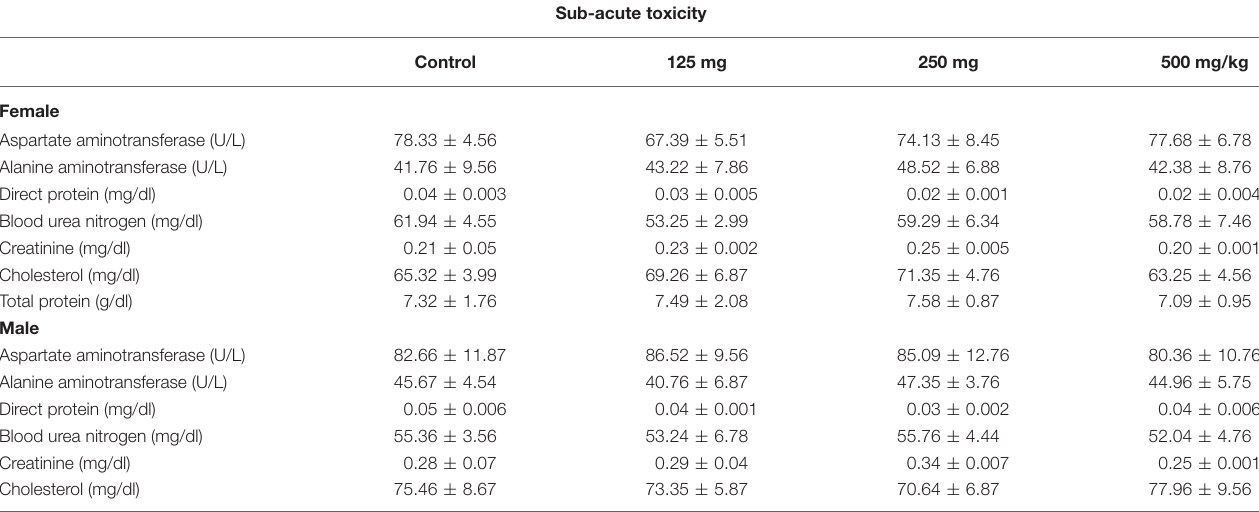
TABLE 3 | Effect of fungal taxol on the biochemical parameters of the control and the treated female and male Wistar rats in the sub-acute toxicity study.